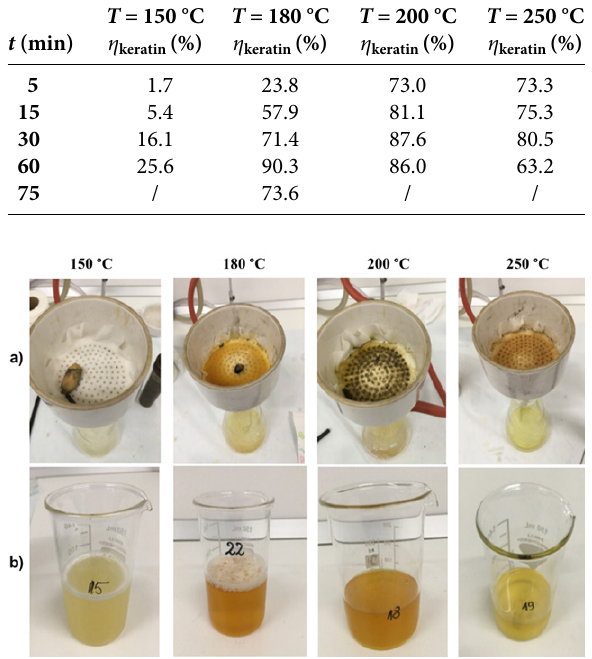
Figure 1 . Reaction products at 150 °C, 180 °C, 200 °C and 250 °C at the reaction time (60 min); a) wool residues after filtration, b) liquid reaction